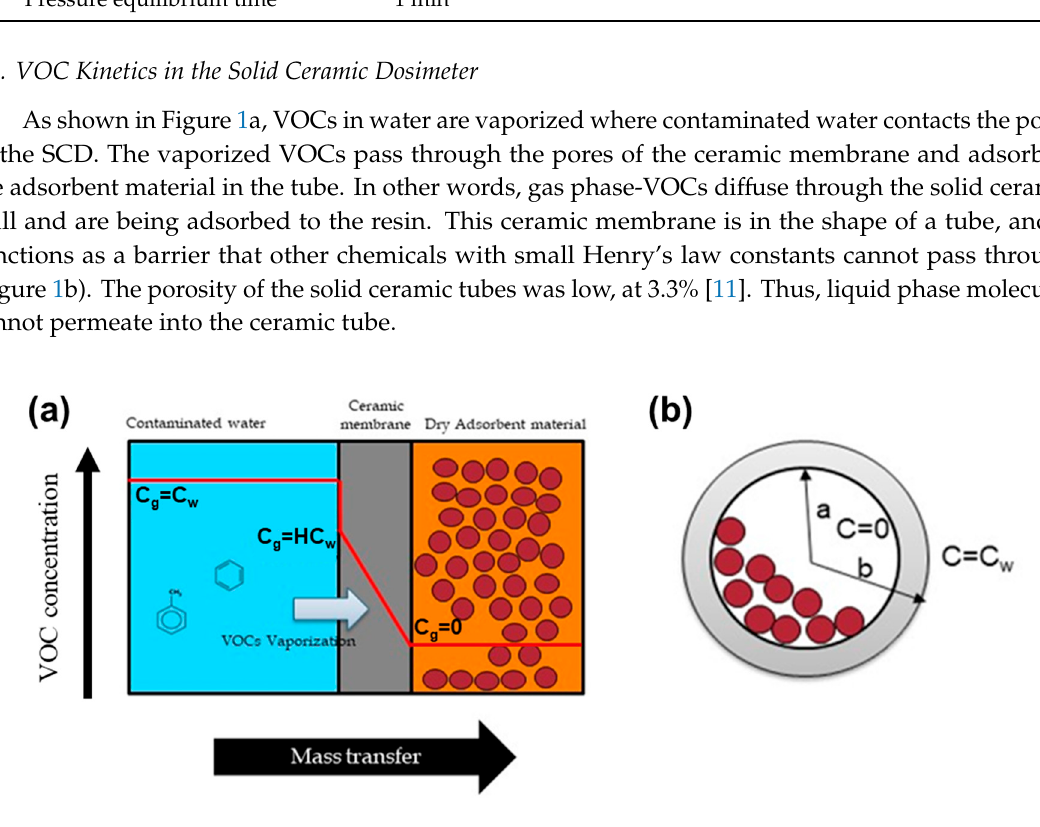
Figure 1. Concentration gradient profile between water and the solid ceramic membrane ( a ) and cross-section of the ceramic tube ( b ). The length of the tube (L) and inner ( a ) and outer ( b ) diameter were 40, 3, and 5 mm, respectively.